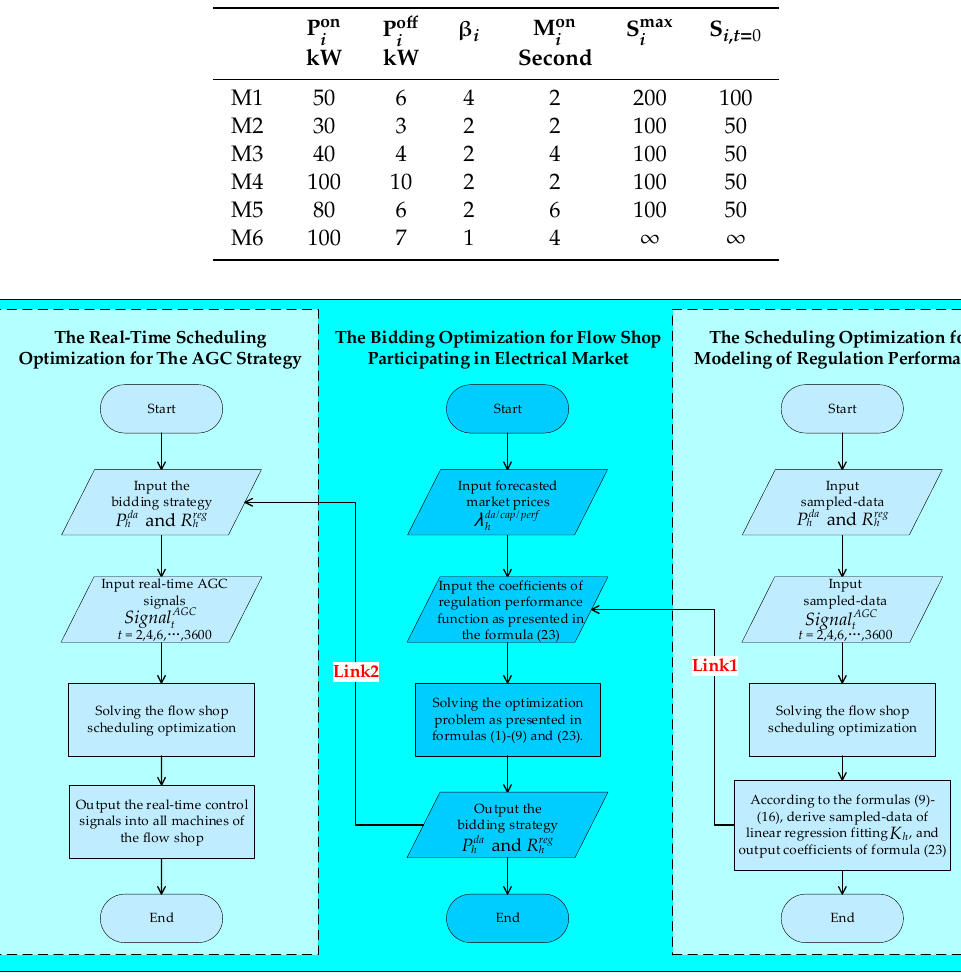
Table 1. The parameters of the flow shop.